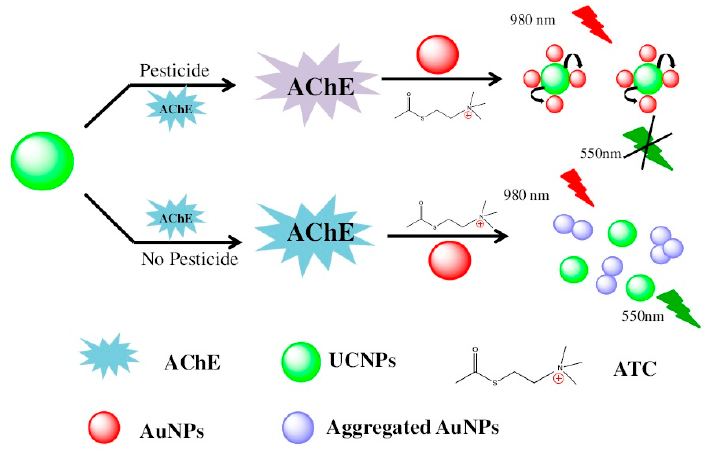
Figure 3. Schematic illustration of the UCNPs–AuNPs fluorescence assay for the detection of pesticides. Reprinted with permission from [38]. Copyright (2015)